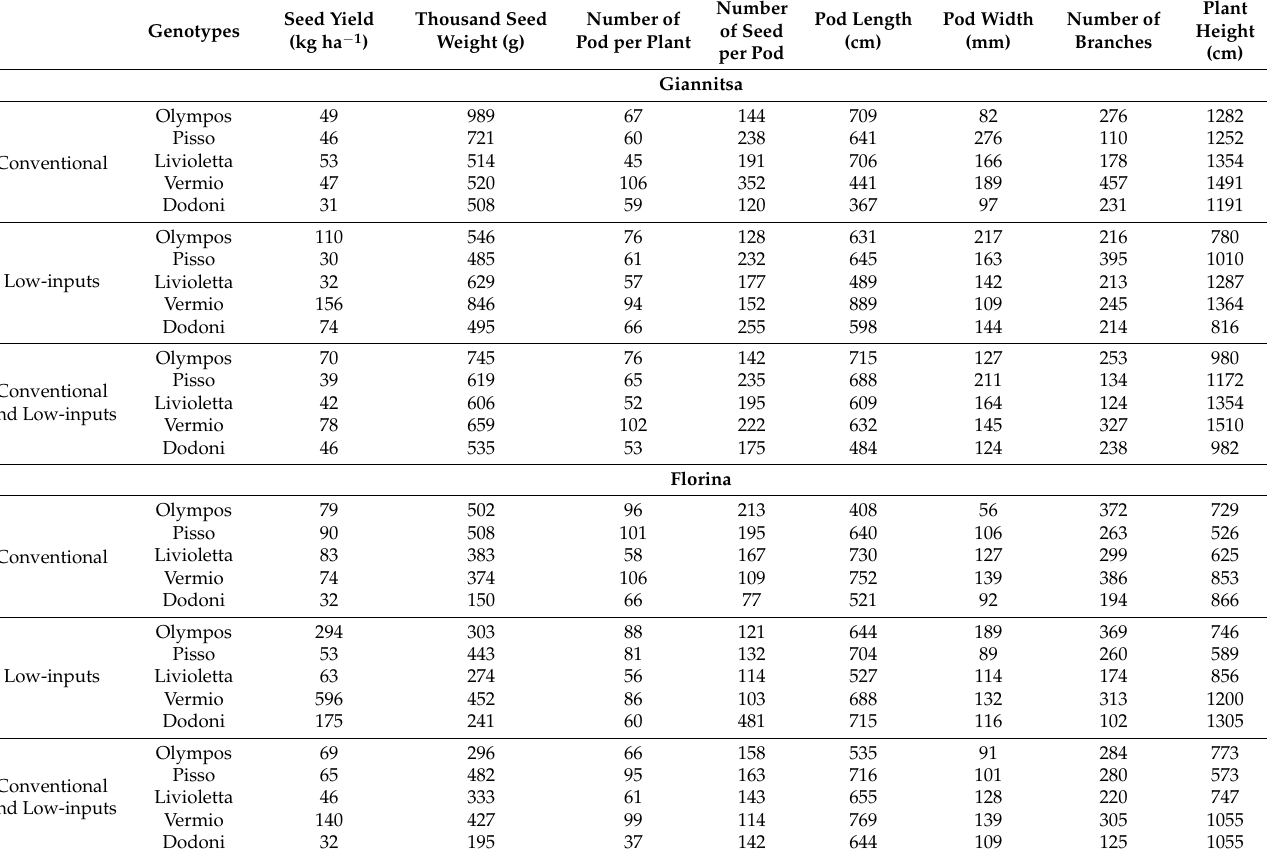
Table 4. Combined trait stability index across genotypes and environments, for the two farming systems: seed yield (kg ha − 1 ), thousand seed weight (g), number of pod per plant, number of seed per pod, pod length (cm), pod width (mm), number of branches and plant height